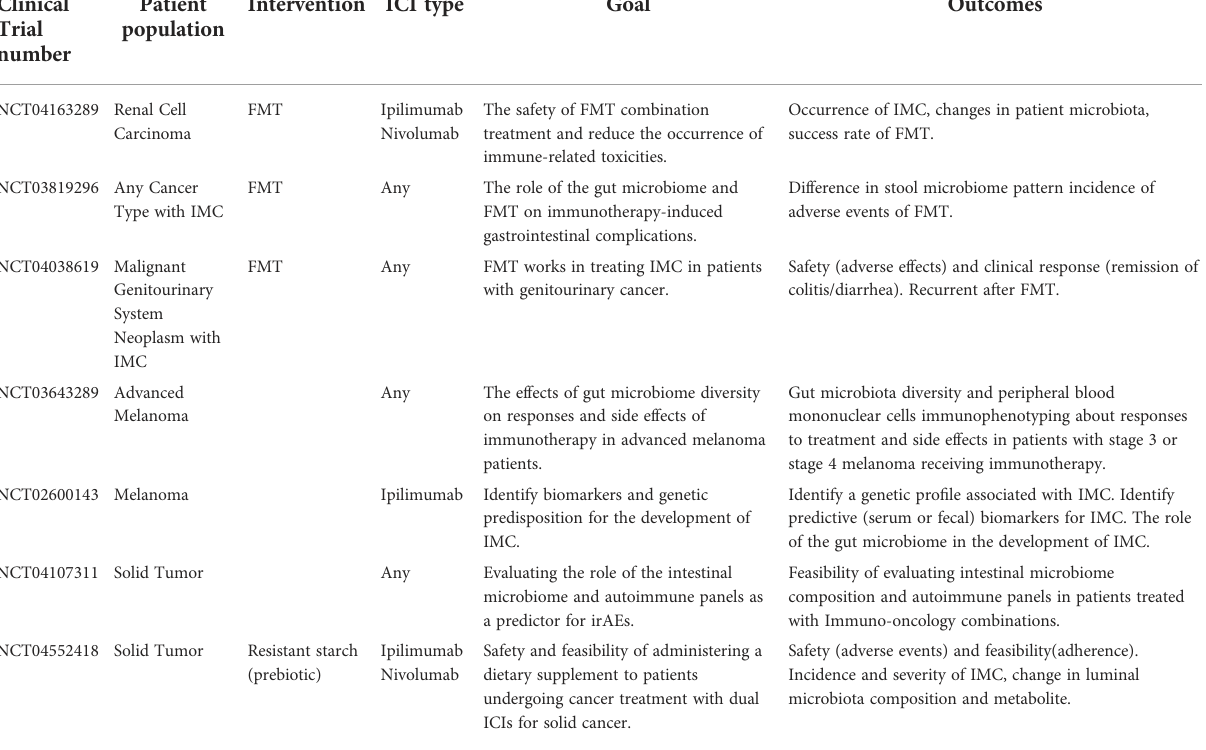
TABLE 2 Clinical trials of intestinal microbiological intervention for IMC patients. Clinical